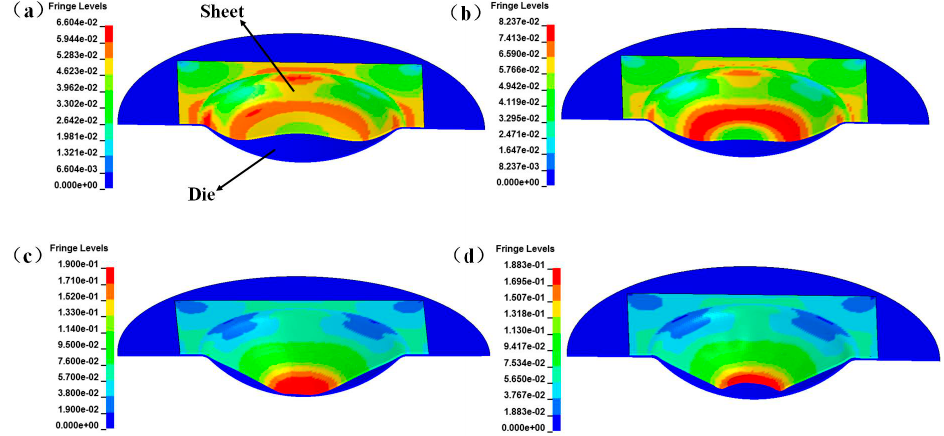
Figure 13. Numerical simulation of the plastic strain distribution during a high-speed electromagnetic impaction process with the die at a discharge voltage of 10 kV: ( a ) 80 μ s; ( b ) 120 μ s; ( c ) 180 μ s; and ( d ) 300 μ s.